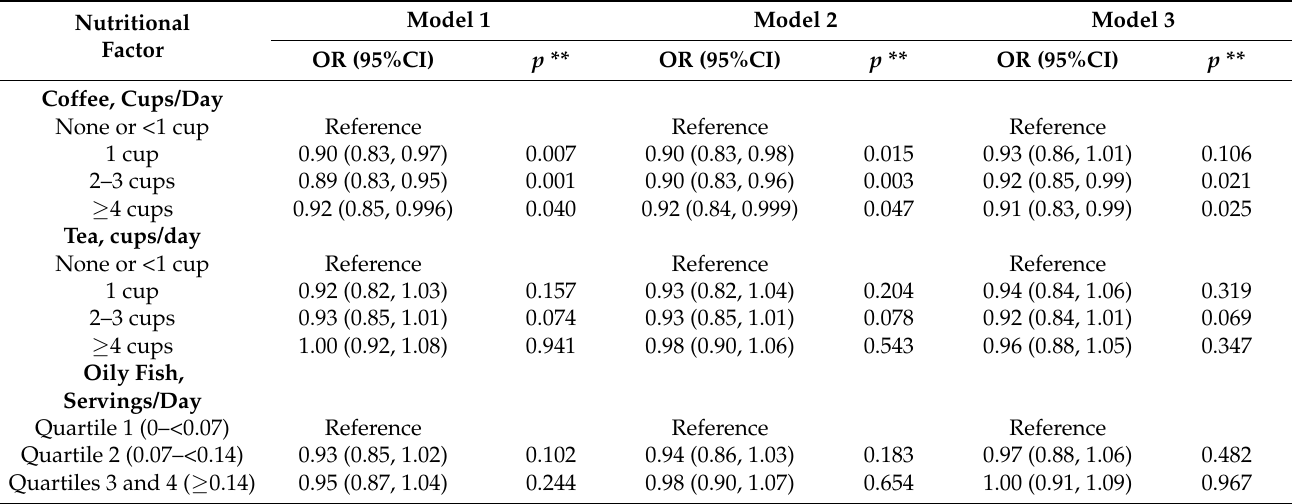
Figure 1. Total COVID-19 Positive Tests in Wave 1 compared to Wave 2 by UKB ( A ) and National (UK) ( B ) Data ** The UKB geo-data and National (UK) COVID-19 surveillance data was imported, projected, and converted to be compatible with each other in ArcGIS for visual inspection (see COVID-19 exposure in Materials and Methods section for more details). Wave 1: Total positive tests for March-August 2020; Wave 2: Total positive tests for September–November 2020; Source: UKB and https://coronavirus.data.gov.uk/ accessed on 4 April 2021. Table 2. Adjusted * OR (95% CI) of having a positive COVID-19 test by nutritional